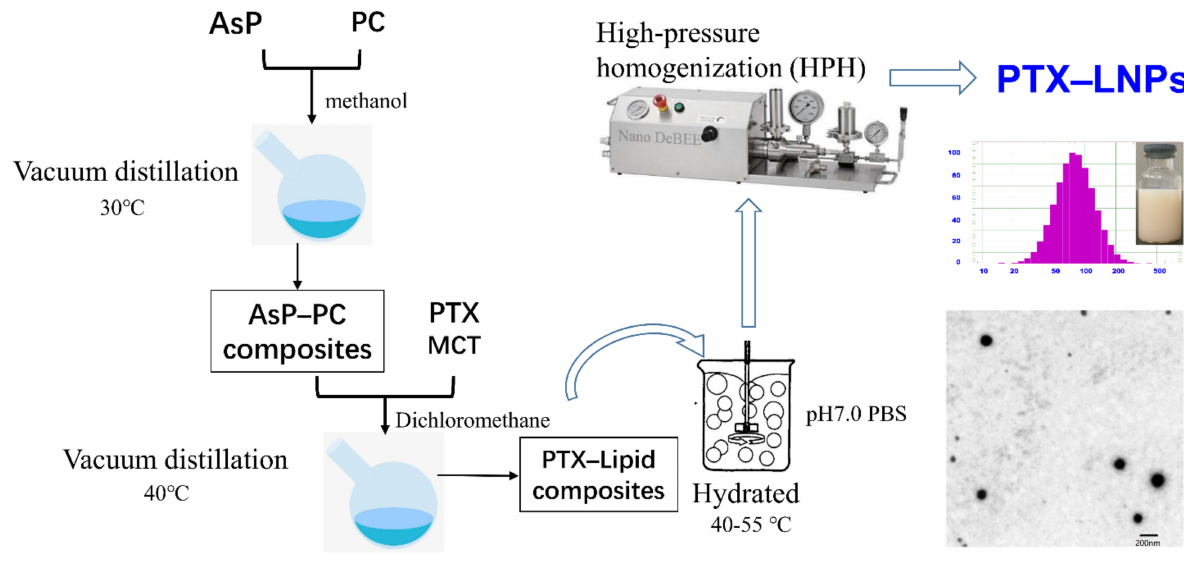
Figure 2. Main preparation process of